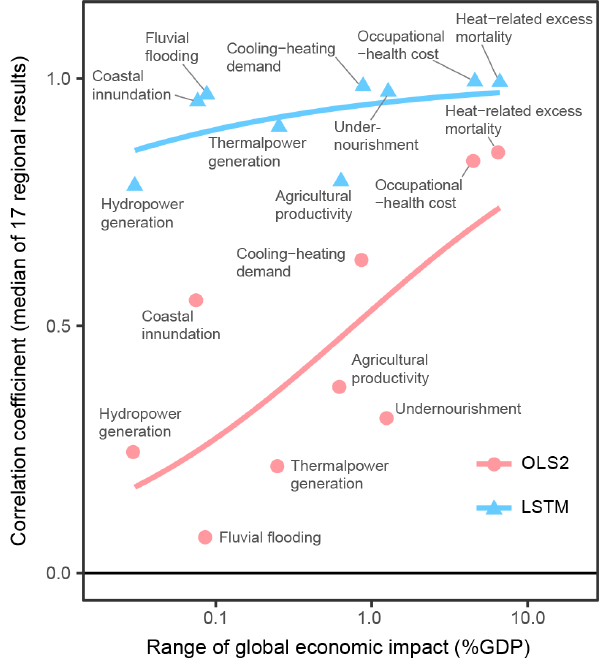
Figure 7. Relationship between range of economic impacts (global) and performance of emulators. Each point represents a sector, and the median of 17 regional results is plotted as the y axis value. Fitted curves are produced by beta regression. OLS2 uses only the global mean temperature as the input variable, and LSTM uses all the pre- pared input variables for 95